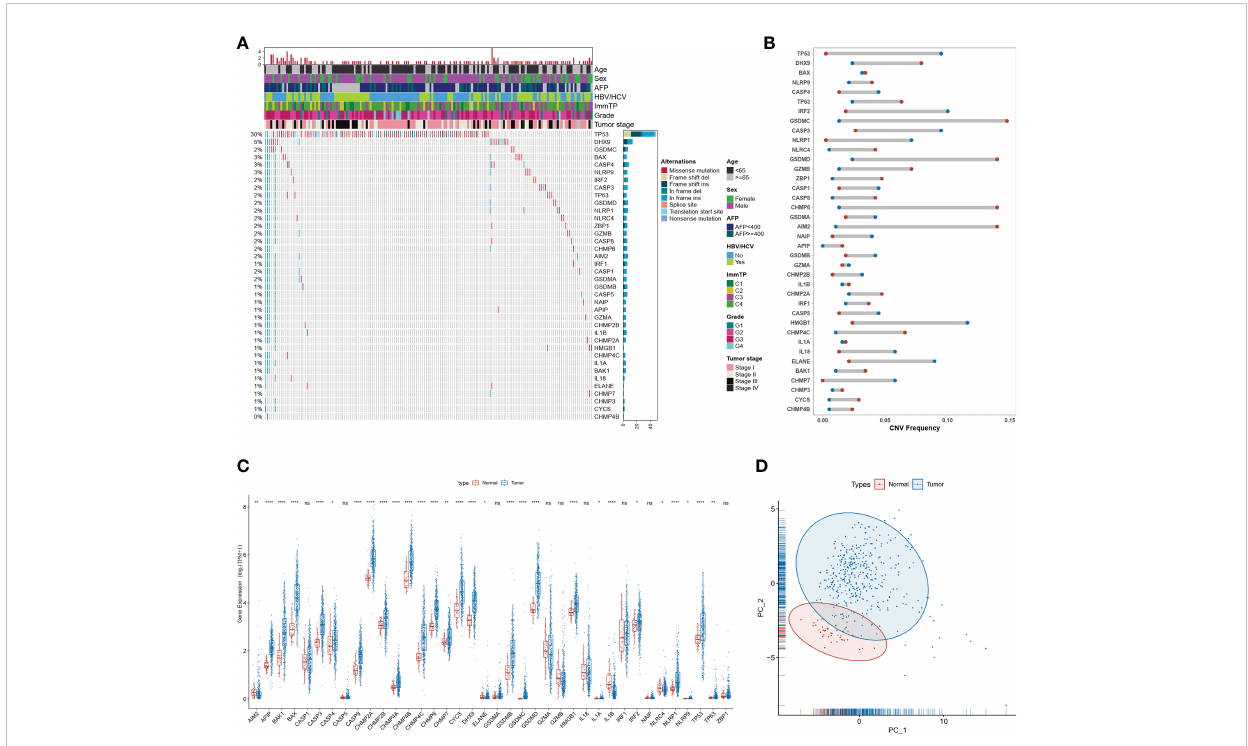
FIGURE 1 Genetic and transcriptional alterations of PRGs in HCC. (A) Mutation frequencies of 40 PRGs in the TCGA-LIHC dataset; (B) Frequencies of CNV gain (red dots), loss (blue dots), in HCC compared to normal tissue among PRGs; (C) Expression distributions of 40 PRGs between normal and